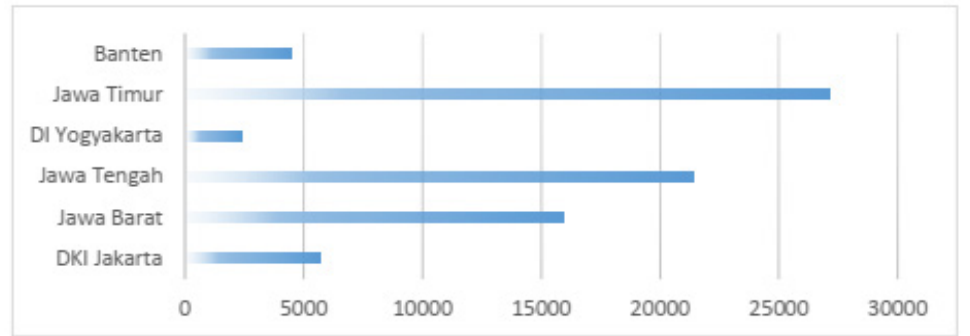
Figure 2: Number of Active Cooperatives in Java Island